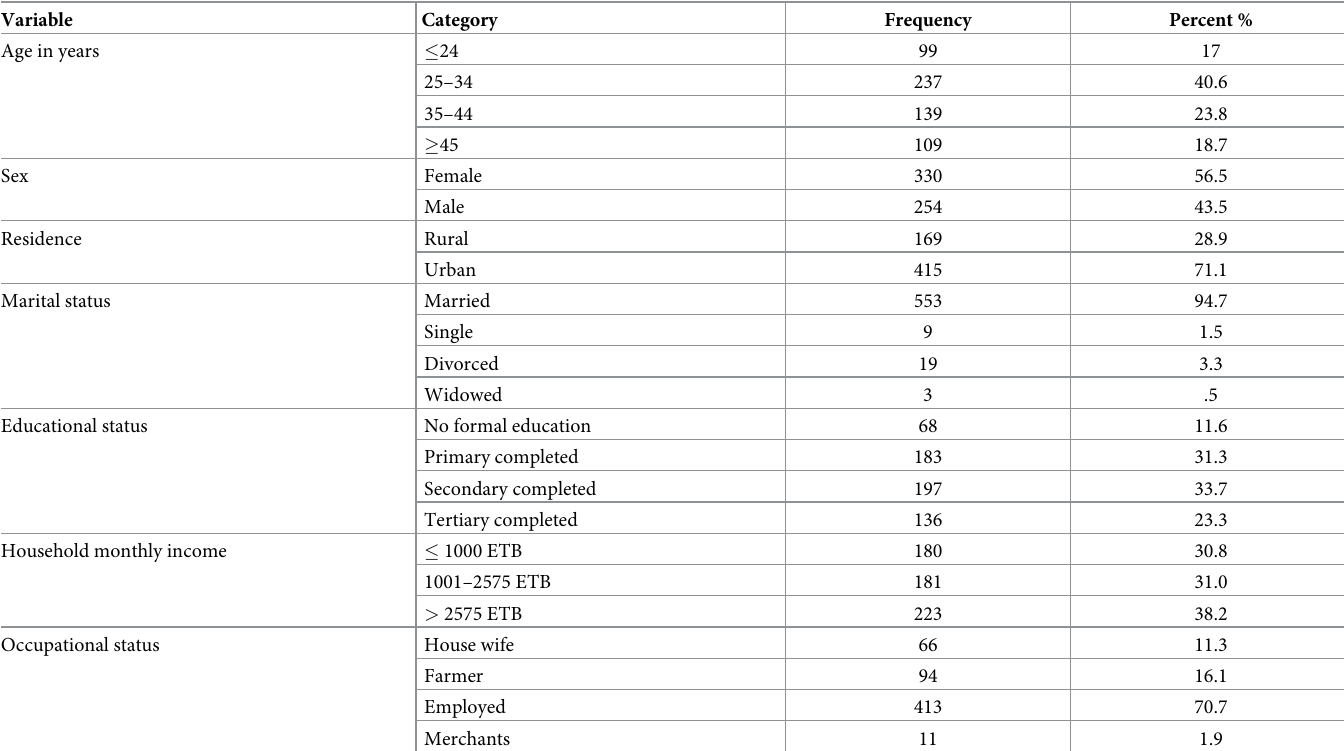
Table 1. Socio-demographic and economic characteristics of respondents at Hawassa City, South Ethiopia, 2020.